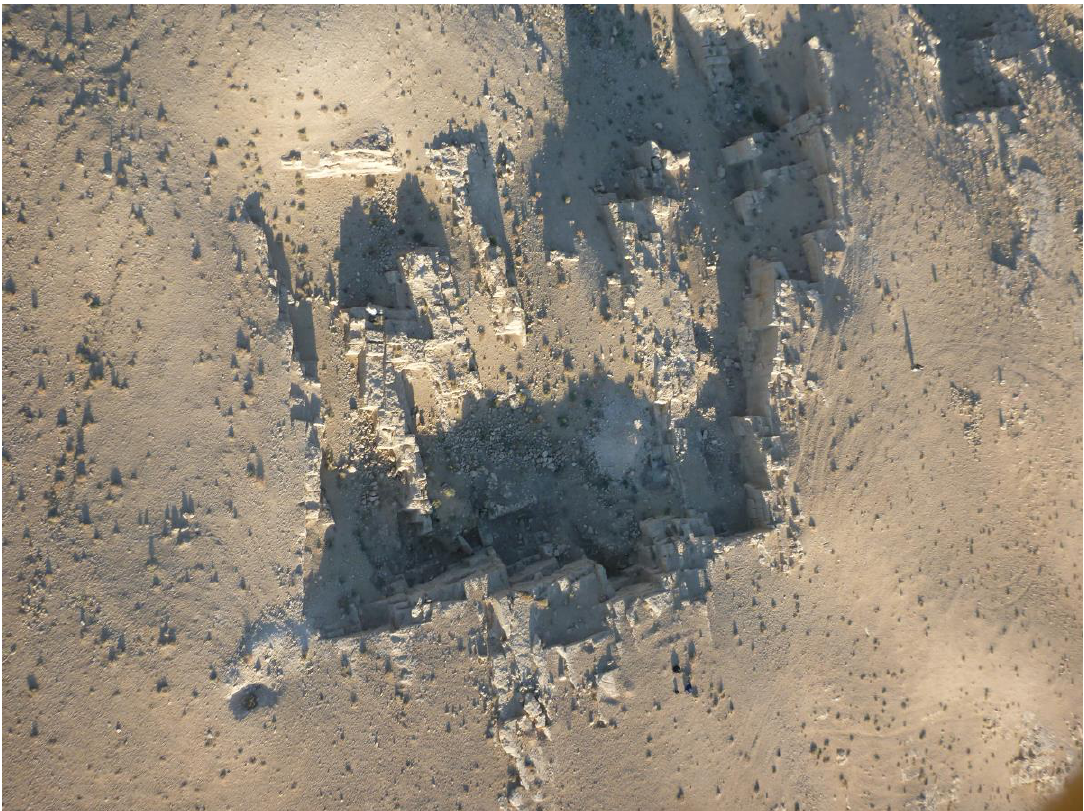
Figure 7. Typical aerial photograph of one part of the